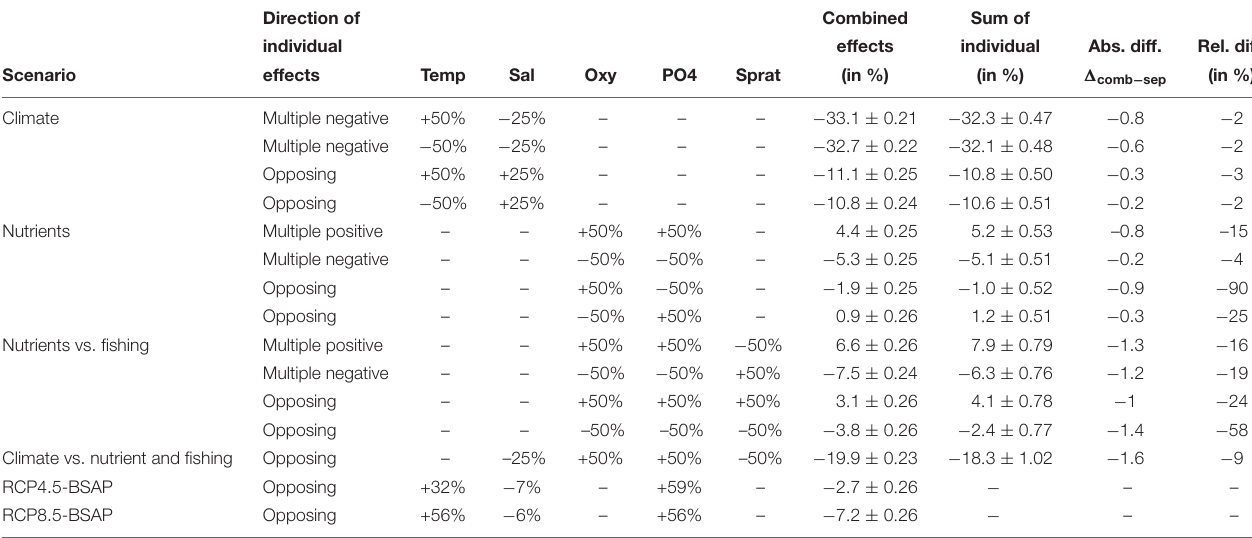
TABLE 1 | Summary of scenarios and effect sizes under multiple environmental